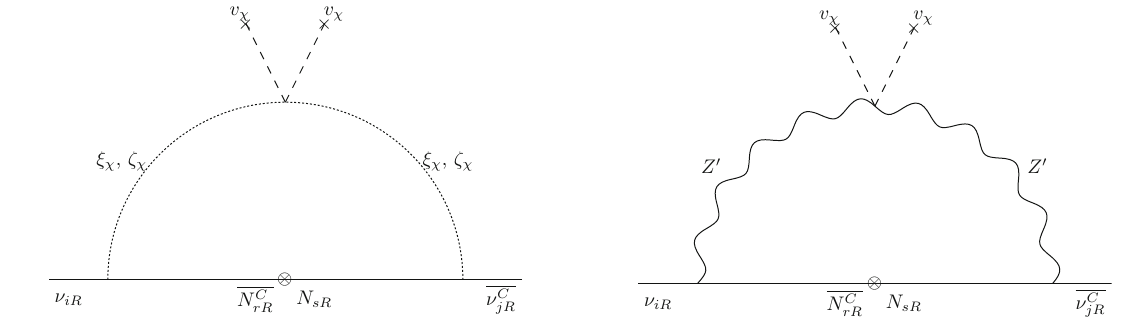
Fig. 2 Feynman diagram contributing to the 22 block of the full neutrino mass matrix. Here, i , j , r , s = 1 , 2 , 3 and the cross mark ⊗ in the internal lines corresponds to the Majorana mass terms induced by the dimension twelve Majorana neutrino Yukawa interactions of Eq.